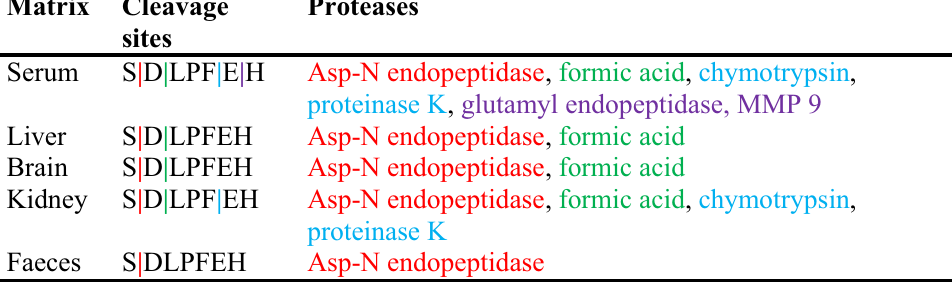
Table 4. Overview of cleavage sites and in silico predicted responsible